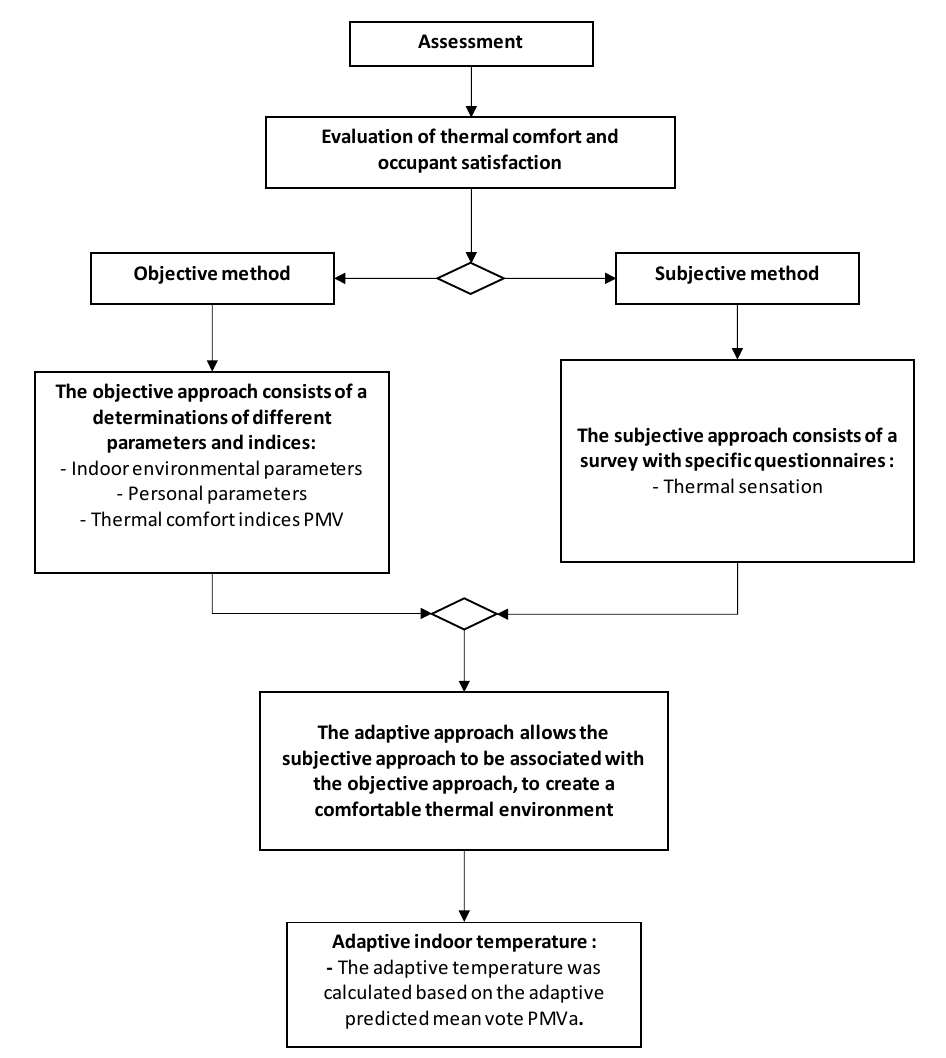
Figure 1. Flowchart of the methodology used.